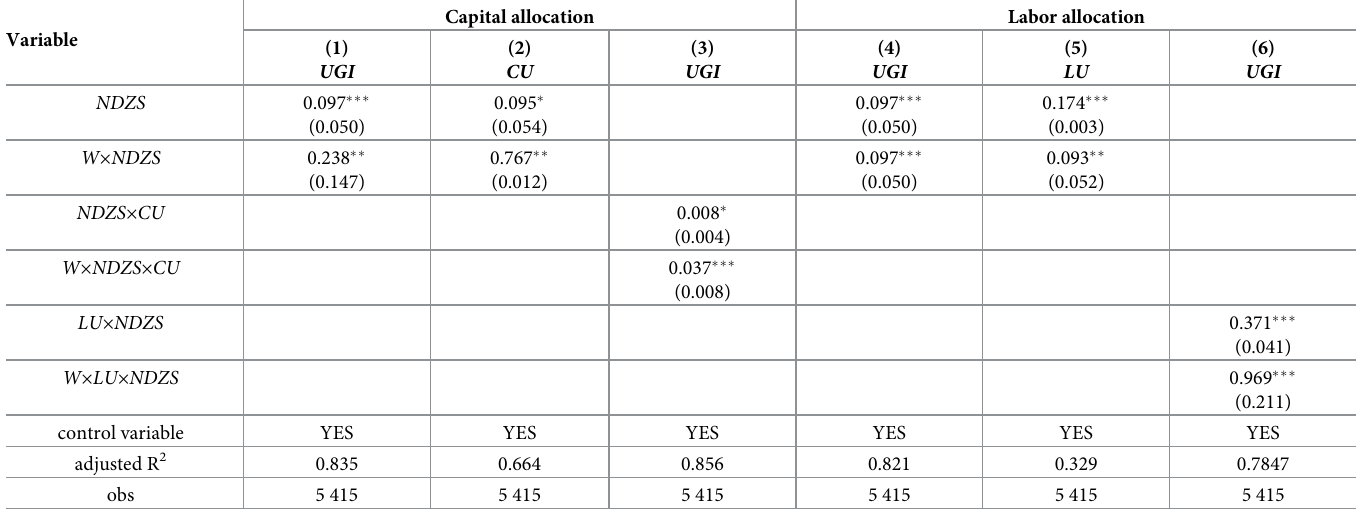
Table 12. Mechanism test-resource allocation